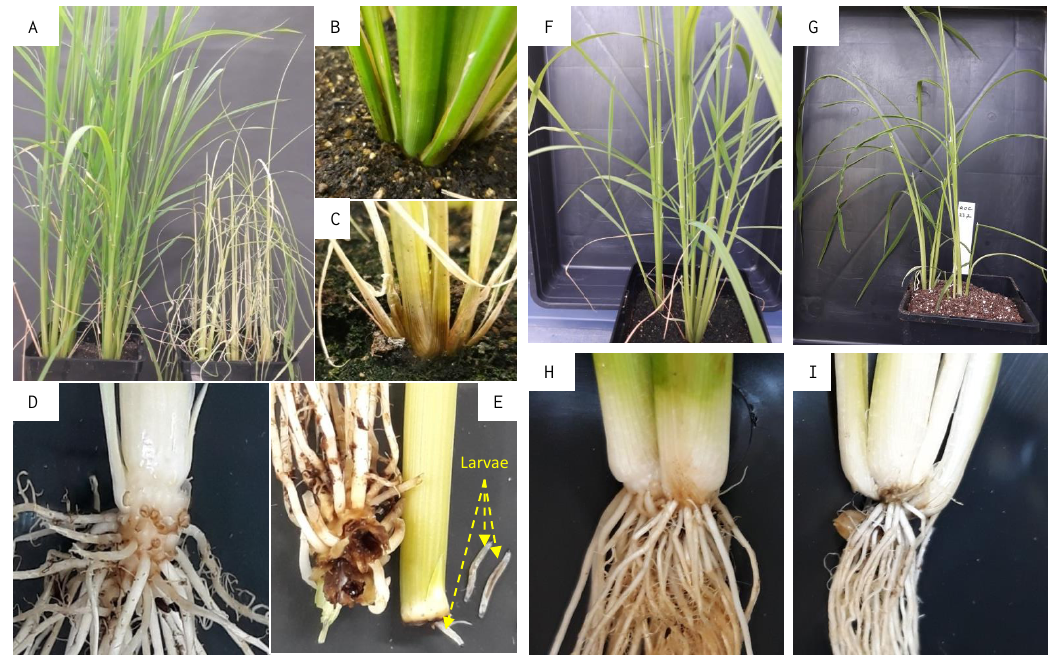
Figure 2. The JA biosynthetic osaoc mutant succumbs to attack by larval of the soil fly fungus gnats Bradysia spp . (Diptera: Sciaridae). In the greenhouse conditions, homogenous mutant plants ( osaoc / osaoc ) were planted next to the heterozygous and wild type plants in the soil. Larvae were able to attack to the stem of the homogenous mutants, result in wilting and plants dying after few days, while the wild type plants were just attacked on some roots and had no obvious symptoms on the above-ground part. The assay was repeated at least three times with the total observation of homozygous mutants of more than 100 plants. When a fly trap was applied, or the soil treated with larvacide (VectoBac), or 10 µM of JA applied through spraying on leaf or soil, the mutant plants were able to survive until flowering. The figure shows the wild type plants ( A (plants on the left), B , and D ) and the homozygous mutant plants ( A (plants on the right), C , and E ) with the wilting symptom on their leaves and the larvae found in the stem of attacked mutant plants. ( F , H ) Healthy heterozygous plants without insect attack. ( G , I ) Healthy osaoc mutant plants without insect attack.